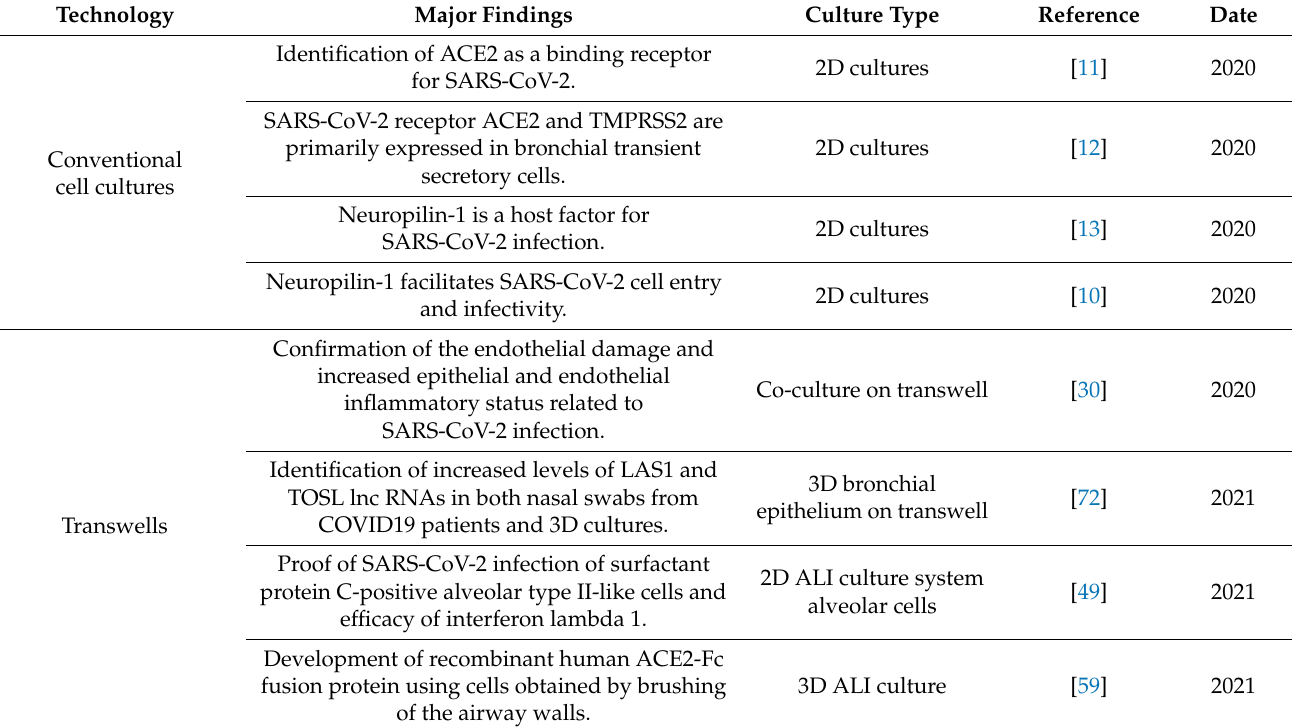
Table 1. Summary of 2D/3D in vitro cultures in COVID-19